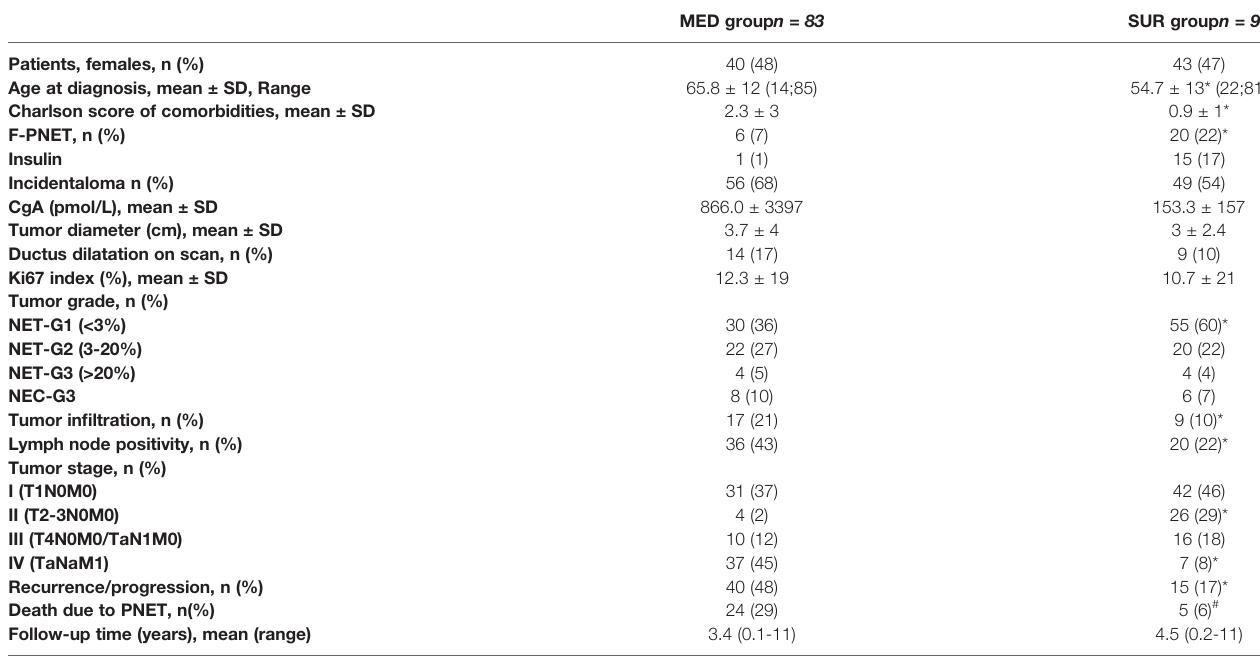
TABLE 1 | Clinicopathological data in 174 patients with pancreatic neuroendocrine tumors divided into surgically treated (SUR group, n=91) and medically treated or non-treated (MED group, n = 83).